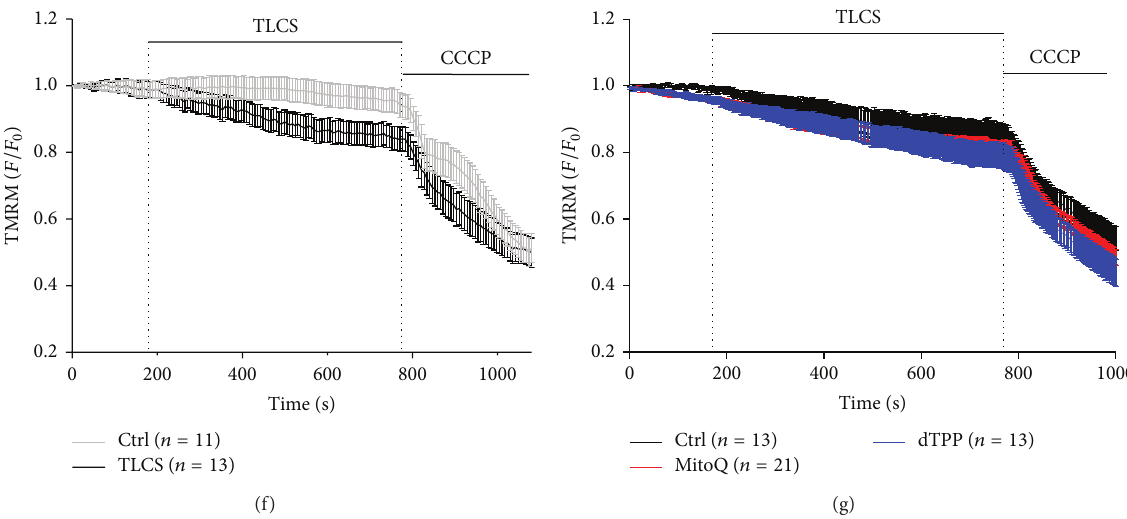
Figure 2: Effects of MitoQ on mitochondrial membrane potential ( ΔΨ𝑚 ) in isolated pancreatic acinar cells. (a) Neither 1 𝜇 M MitoQ nor dTPP had a significant effect on ΔΨ𝑚 per se . In contrast the protonophore CCCP induced complete depolarisation. Mean data (b) and representative images (c) showing that 10 𝜇 M MitoQ and dTPP partially depolarised mitochondria. Application (d) CCK (10nM) or (f) TLCS (500 𝜇 M) caused a fall of ΔΨ𝑚 compared to time-matched controls. However, neither 1 𝜇 M MitoQ nor dTPP pretreatment protected against ΔΨ𝑚 depolarisation induced by (e) CCK (10nM) or (g) TLCS (500 𝜇 M) ( 𝑛 ≥ 3 mice per group). TMRM fluorescent traces are shown as normalised ( F / F 0 ) mean ± SEM.